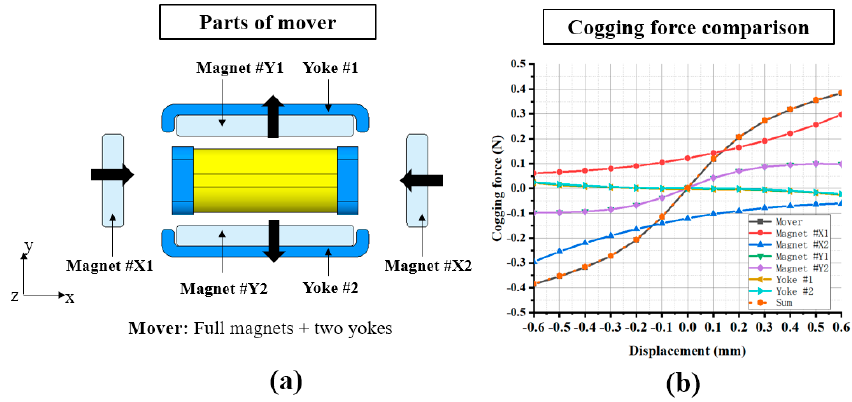
Figure 7. Magnetic mover: ( a ) parts of mover and ( b ) comparison of cogging forces of different parts of mover.